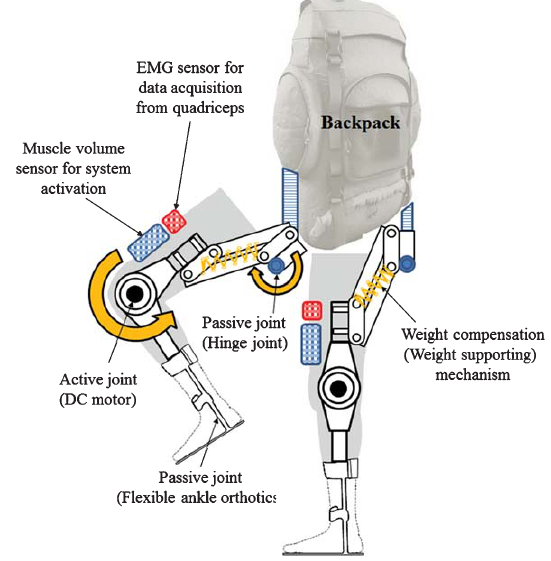
Fig. 8. Calculation of muscle force and external load for actuator selection.